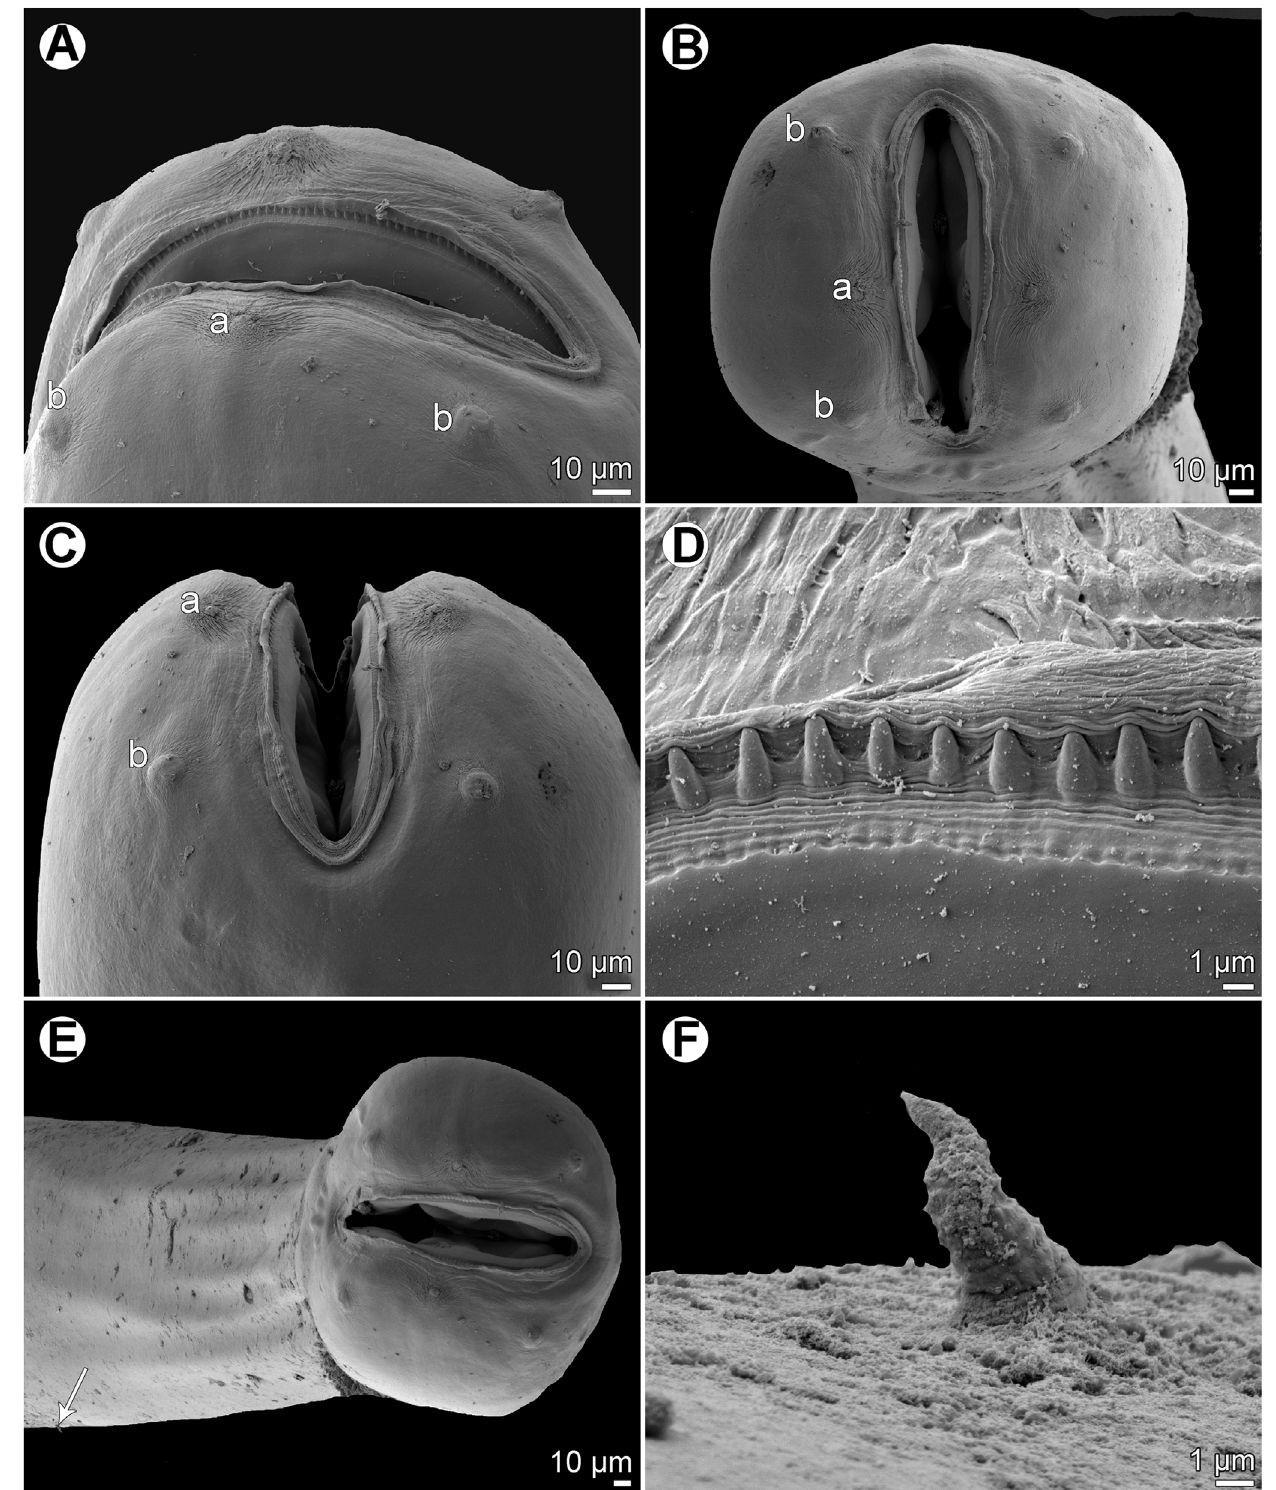
Figure 8. Cucullanus diagrammae n. sp. from Diagramma pictum , scanning electron micrographs of male. (A, B) Cephalic end, sublateral and apical views, respectively; (C) cephalic end, dorsoventral view; (D) detail of peribuccal teeth; (E) anterior end of body, dorsoventral view (arrow indicates deirid); (F) deirid. (a) Amphid; (b) cephalic